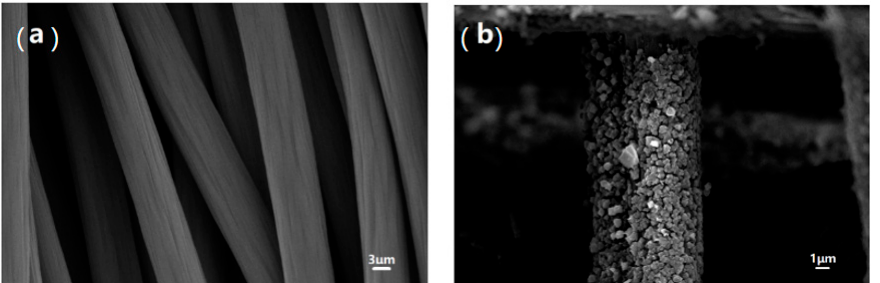
Figure 1. SEM images of unmodified carbon felt ( a ) and in-situ grown MIL-53(Fe)@CF photocata- lytic membrane ( b ).